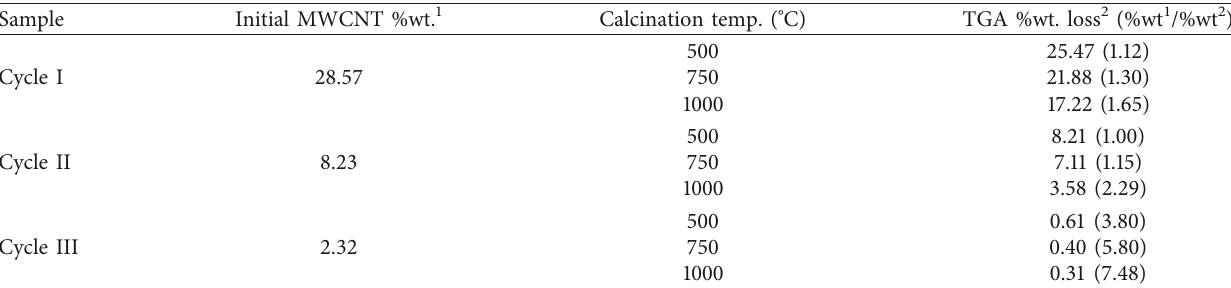
2 -coated MWCNTcomposites prepared with I, II, and III coating cycles and calcined at 500 Table 2: Carbon content in TiO